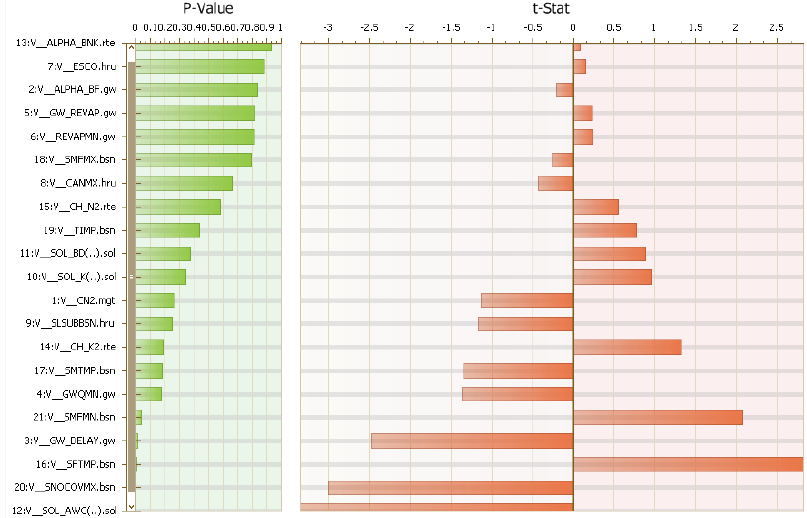
Figure 4. Sensitivity analysis results.